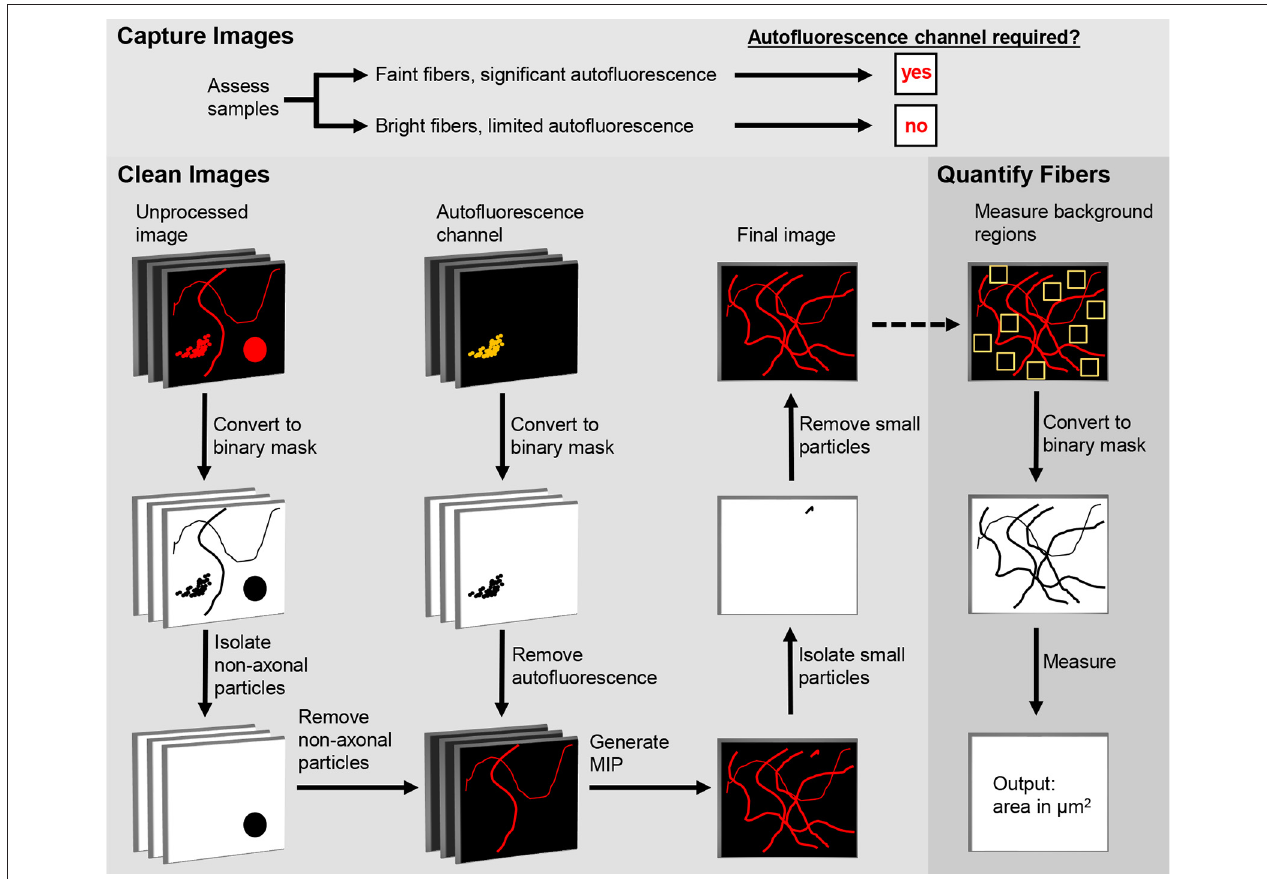
FIGURE 1 | Digital Enhancement of Fibers with Noise Elimination (DEFiNE) workflow. Autofluorescence removal by the Clean Images function depends on capture of an autofluorescence channel during imaging. When samples have brightly labeled axons and limited noise, the autofluorescence channel can be omitted during imaging and processing. The Clean Images and Quantify Fibers functions may be used separately or in tandem, as indicated by the dashed